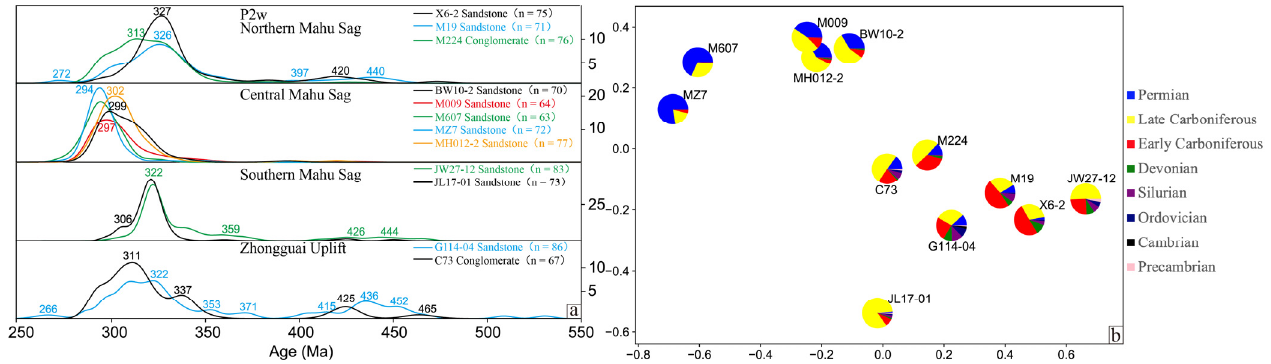
Figure 9. ( a ) Distributions of U-Pb ages of detrital zircons in the Lower Wuerhe Formation in the Mahu-Zhongguai area, northwestern Junggar Basin. ( b ) Multidimensional scaling diagram. The samples were classified according to the similarity of age distribution characteristics and geographical location. The multi-dimensional scaling diagrams can measure the similarity of multiple samples in different locations but in the same period. The locations and details of detrital zircon samples are shown in Figure 1 and listed in Table 1.